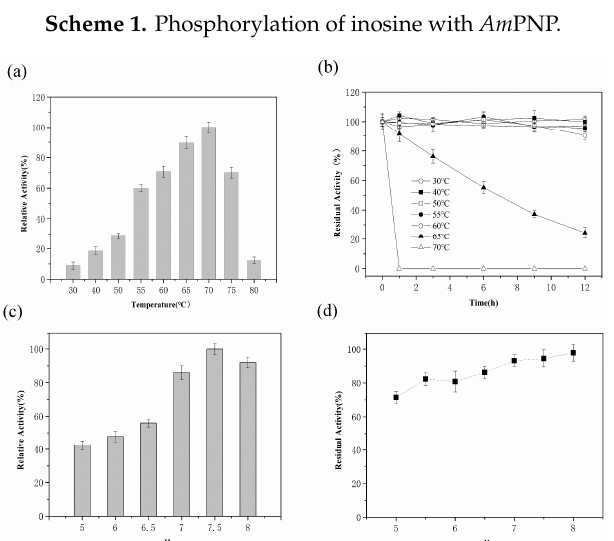
Figure 3. Effects of temperature and pH on the activity and stability of Am PNP. ( a ) Effect of Figure 3. E ff ects of temperature and pH on the activity and stability of Am PNP. ( a ) E ff ect of temperature temperature on the activity of Am PNP. The highest activity was set to 100%. ( b ) Effects of on the activity of Am PNP. The highest activity was set to 100%. ( b ) E ff ects of temperature on stability of Am PNP. The initial activity was set to 100%. ( c ) E ff ect of pH on the activity determined by assaying the activity at 60 ◦ C in 10 mM Na 2 HPO 4 / KH 2 PO 4 bu ff er. The highest activity was set to 100%. ( d ) E ff ect